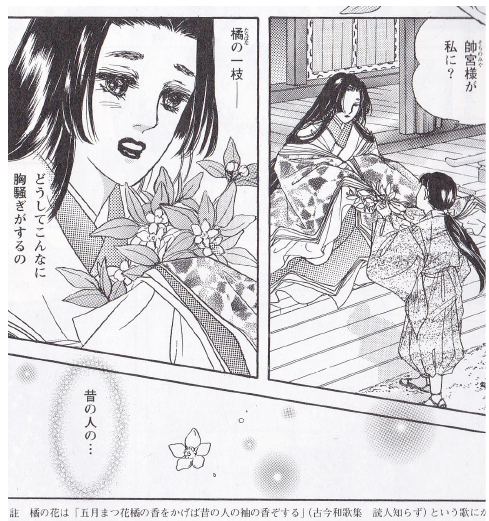
Figure 4. Izumi Shikibu